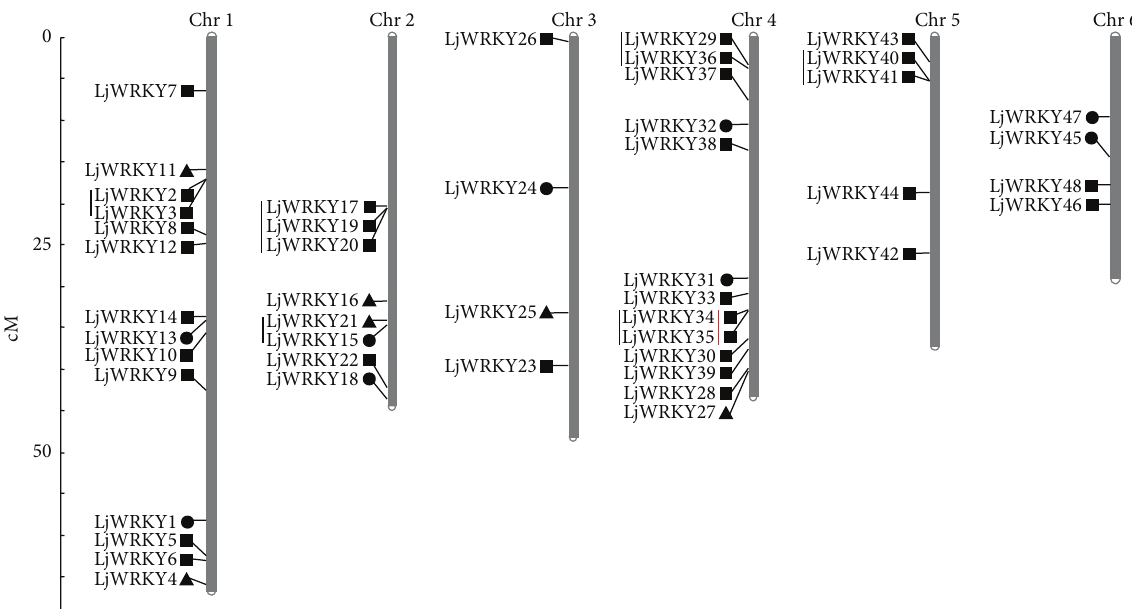
Figure 2: Chromosomal locations of Lotus japonicus WRKY genes. The chromosome numbers were shown at the top of each chromosome (chromosome; gray bars). The names on the left side of each chromosome correspond to the approximate location of each WRKY gene. The markers next to the gene names represented the groups to which each WRKY gene belongs ( e : group I; ◼ : group II; 󳵳 : group III). The black lines on the left side of the names of the WRKY genes indicated the clusters of gene on each chromosome. The red line on the left side of the markers indicated the duplicated genes. Unmapped WRKY genes were not